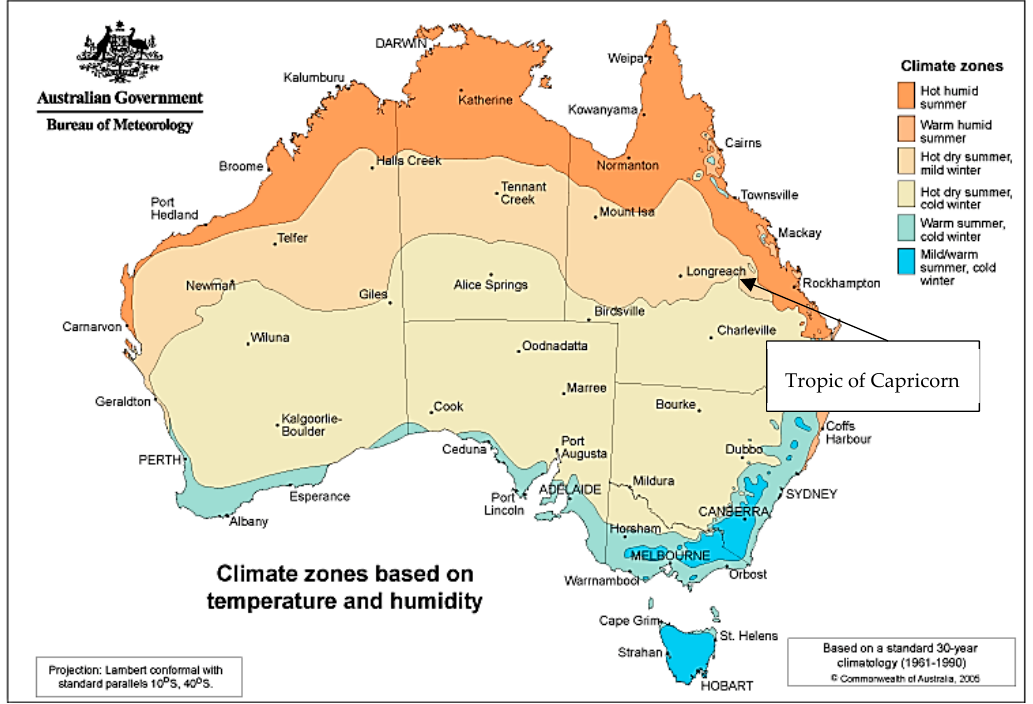
Figure 1. This describes climactic zones. Zone 1 (dark orange, tropics), which is entirely in the tropical north, is defined by high humidity summer and warm winter, zone 2 (light orange, sub-tropics) is defined by warm humid summers and mild winters, and zone 3 (yellow, sub-tropics) is defined by hot dry summers and warm winters. (Australian Government, Bureau of Meteorology, Climate Classification Map).